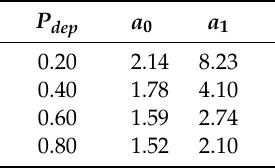
Table 4. Obtained constants a 0 and a 1 in Equations (10) and (11), for di ff erent probabilities of depassivation, P dep